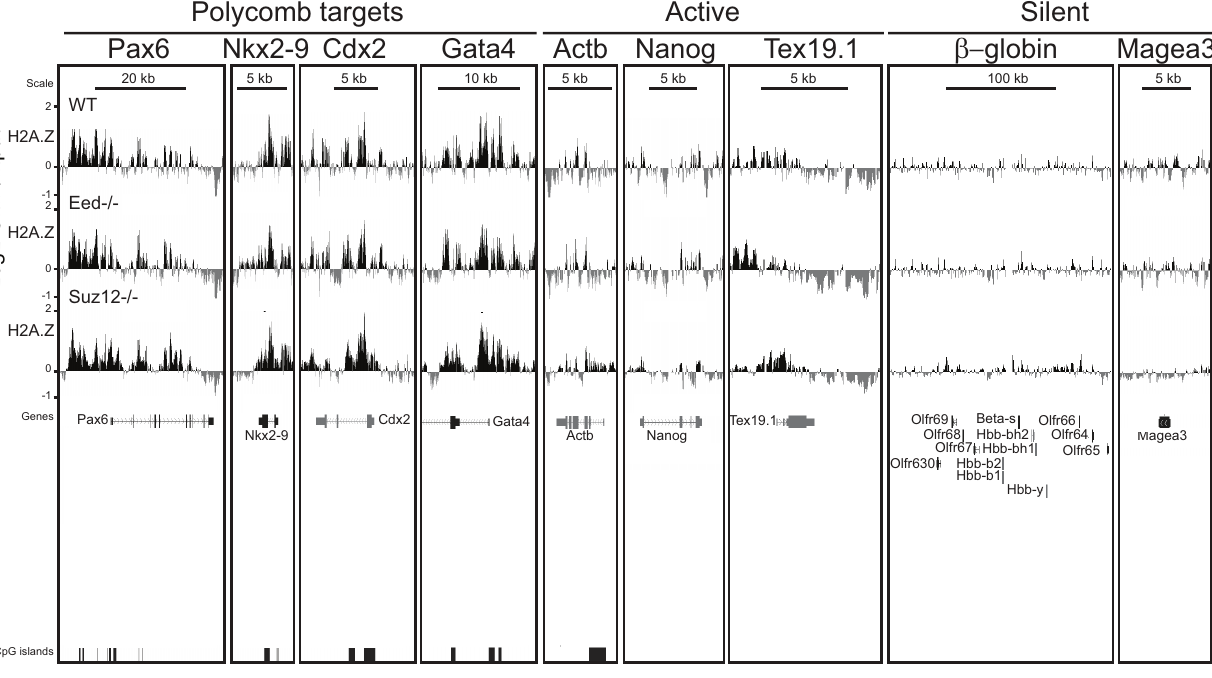
Figure 7. H2A.Z maps to developmental genes in wild-type Suz12 2 / 2 and Eed 2 / 2 mutant ESCs. Log2 of ChIP: input for: H2A.Z WT ( + / + ) (top), Eed 2 / 2 (mid) and Suz12 2 / 2 (bottom) ESCs using a custom tiling microarray. Data is shown for selected polycomb target genes ( Pax6, Nkx2-9, Cdx2 and Gata4 ), active genes ( Actb, Nanog and Tex19.1 ) and silent genes ( b -globin locus and Magea3 ). The data represent a mean of 2 biological replicates. RefSeq gene annotations and CGIs are from the July 2007 (mm9) Build 37 assembly of the mouse genome (genome.ucsc.edu).